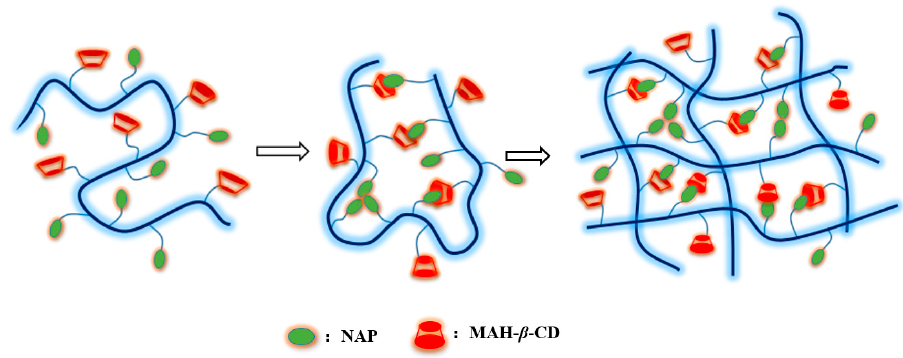
Figure 7. Apparent viscosity as a function of copolymer concentrations for HGP, GP-T, HP-T, and HPAM at shear rate of 170 s − 1 at 25 °C.